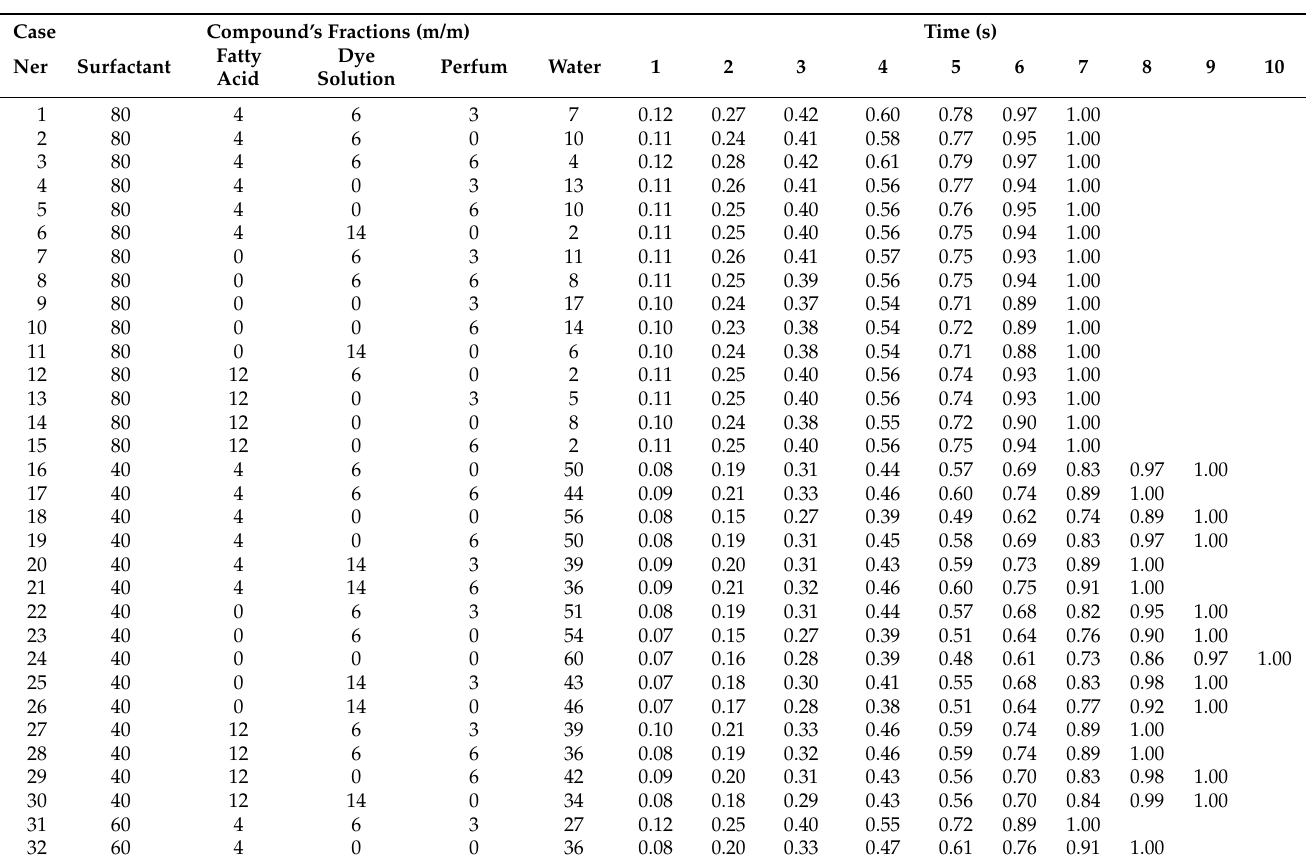
Table 3. Scenarios table. Each scenario is defined by the percentage of each mixture compound, the percentage observed in the table columns from the second to sixth. The following columns show the Homogeneity function for the different times in seconds.